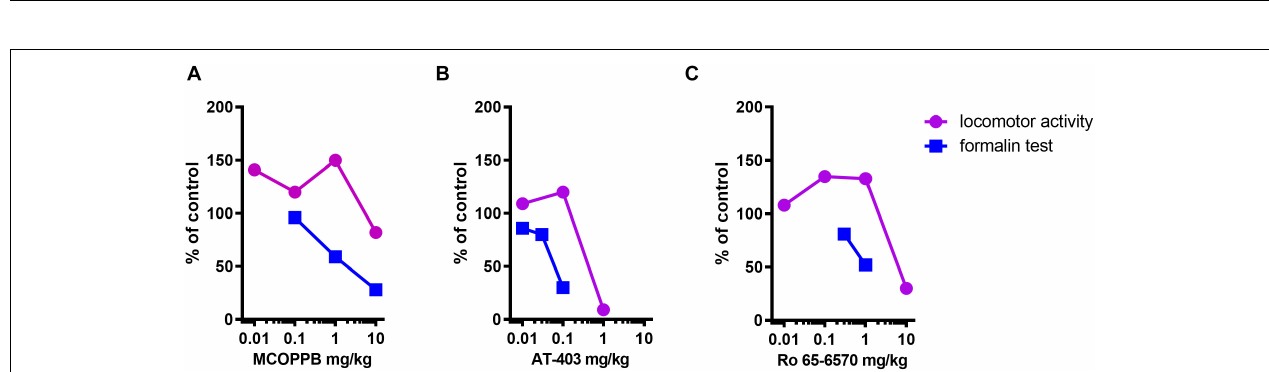
FIGURE 7 | Dose response curves to AT-403 i.p. injected, (A) , MCOPPB i.p. injected, (B) , and Ro 65-6570 i.p. injected for the LA test and i.v. injected for the formalin assay, (C) in the formalin and locomotor activity tests. Data are expressed as% of control, where baseline corresponds to vehicle treated animals. For the LA assay data referred to the total distance traveled, while for the formalin assay data referred to the second phase. These curves (bottom and top constrained to 0 and 100%, respectively) have been used for ED 50 extrapolation and therapeutic index calculation.